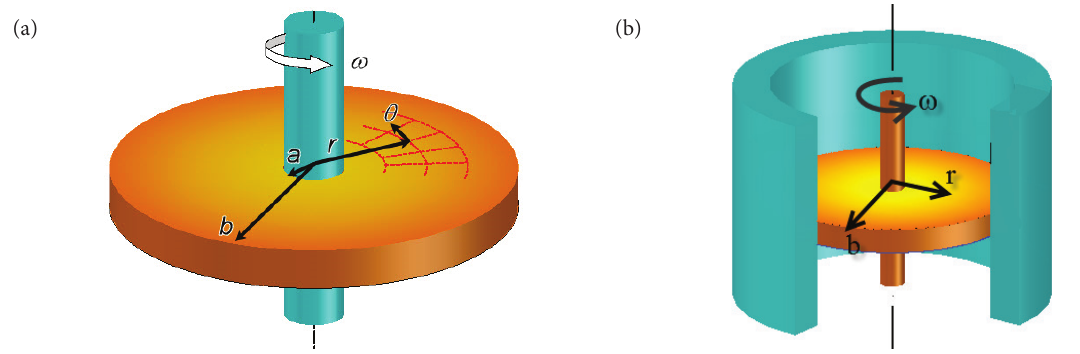
Figure 1. Mounted discs (a) without rigid casing (fi xed-free), and (b) with rigid casing (fi xed-fi